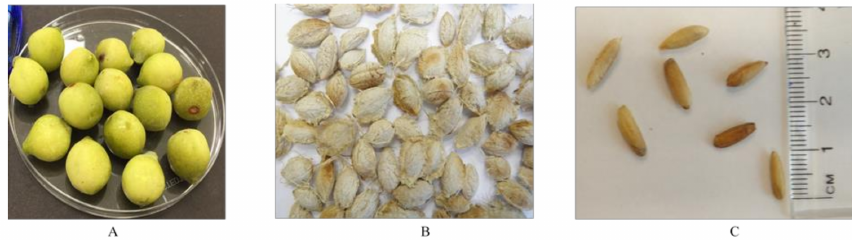
Figure 1. Terminalia ferdinandiana tissues. ( A ) Fresh fruits; ( B ) Dried seeds; ( C )